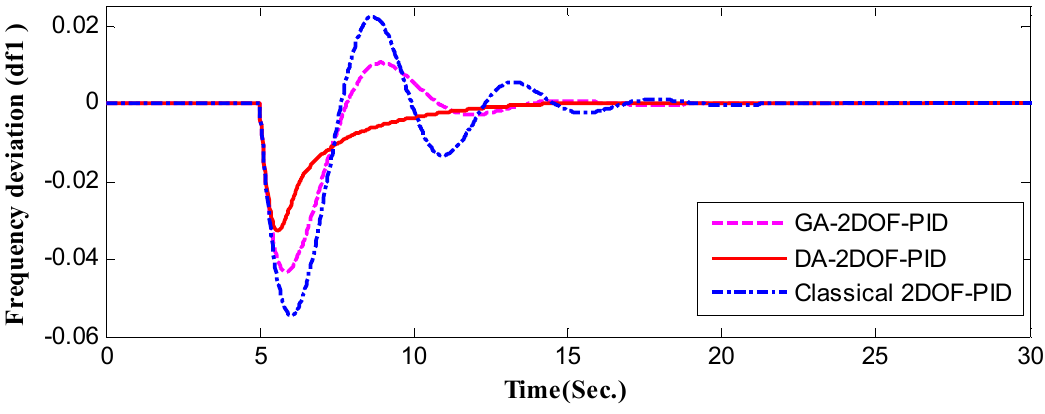
Figure 20. Δ P using GA using GA implementing ITAE, IB-WGFF and classical 2DOF-PID. Figure 20. ∆ P using GA using GA implementing ITAE, IB-WGFF and classical 2DOF-PID.